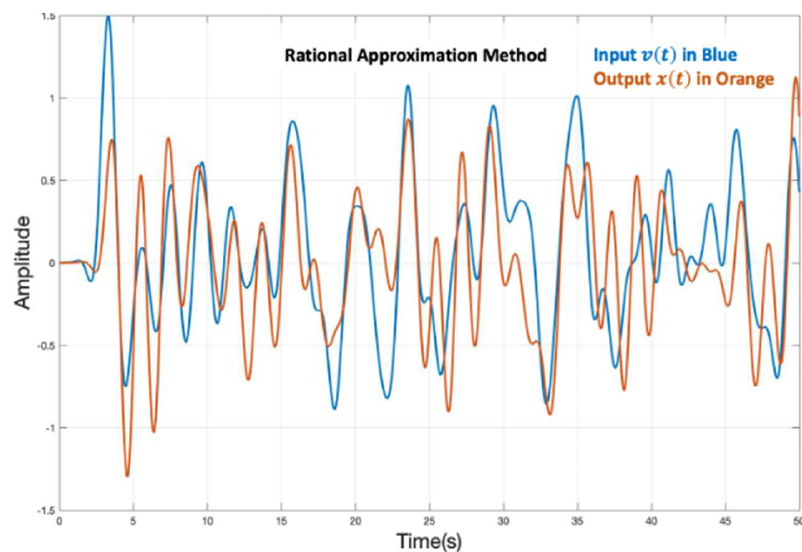
Figure 16. Impact of Control Noise on Control Performance (Technique 1).